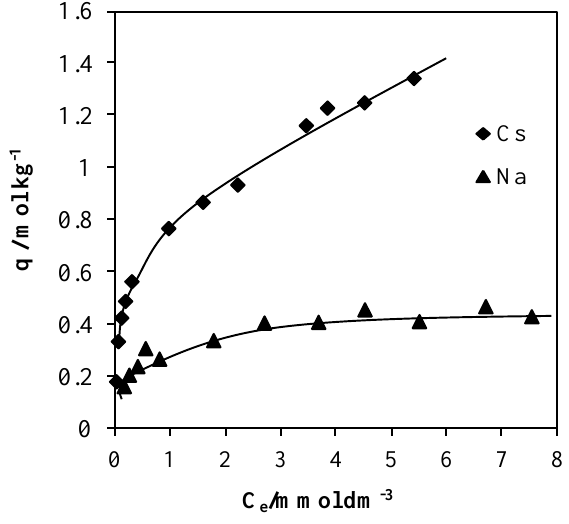
Figure 6. Adsorption isotherms of cesium(I) and sodium(I) ions on CPT gel [17] (with permission for reuse from Elsevier